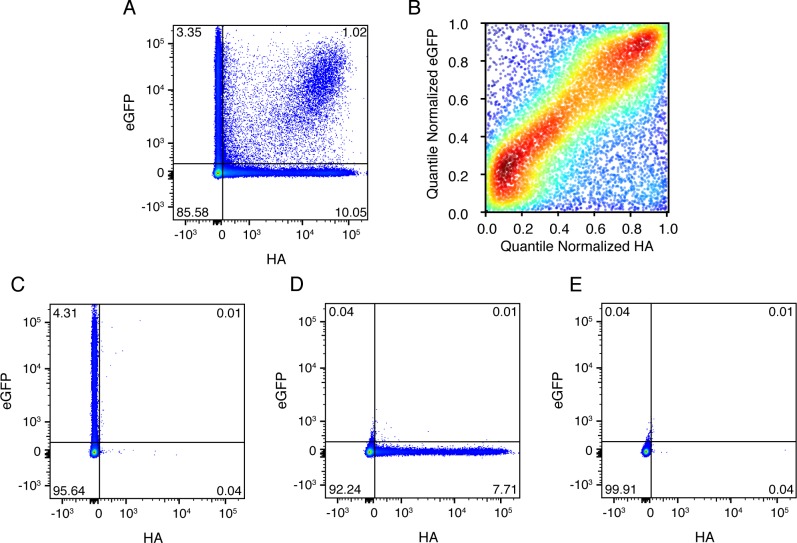
Co-infected cells express roughly equal amounts of a gene from each infecting viral variant.(A) Cells were co-infected with a mix of wild-type virus and virus in which the HA gene was replaced by GFP flanked by the terminal regions of the HA gene segment. At 10 hr post-infection, cells were analyzed by flow cytometry for HA and eGFP expression. (B) The expression of HA and GFP are correlated in co-infected cells. Shown are the quantile-normalized HA and eGFP signals for double-positive cells. Cells are colored by density, using a Gaussian kernel density estimate. (C) ,(D), (E) Gating controls, single infection with eGFP virus, single infection with wild-type virus, and uninfected cells, respectively. .